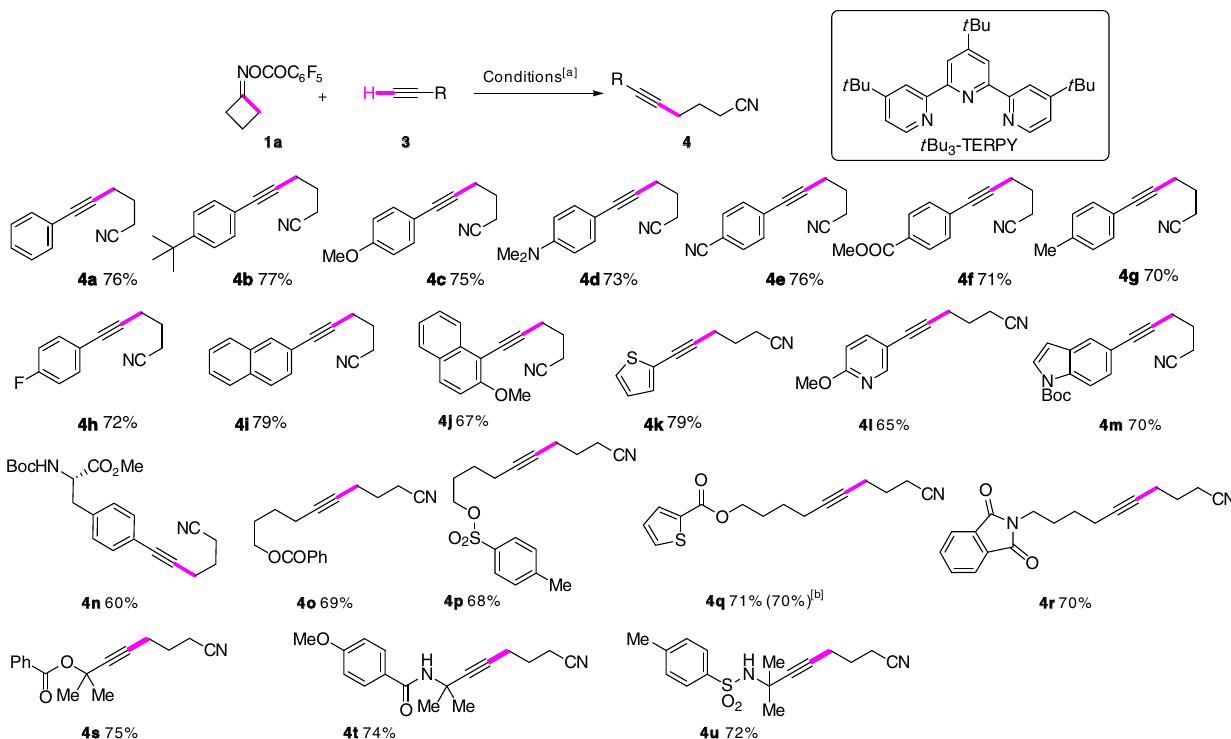
Fig. 2 Cu-catalyzed reductive coupling of cyclobutanone oxime ester with terminal alkynes. [a] 1a (0.2 mmol), 3 (0.4 mmol), CuI (0.1 equiv), t Bu 3 - TERPY (0.2 equiv), K 2 CO 3 (2.0 equiv), CH 3 CN (1.0 mL, c 0.2 M), 60 °C, under nitrogen atmosphere. Yields refer to the isolated products. [b] Reaction performed at 2.0 mmol